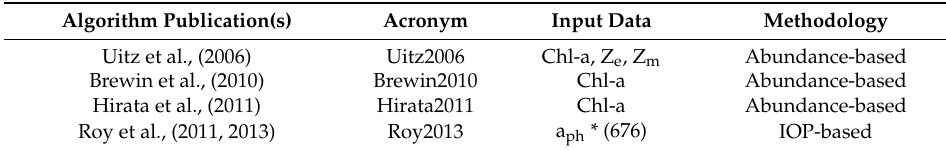
Table 1. Overview of the PSCs algorithms used in this study.